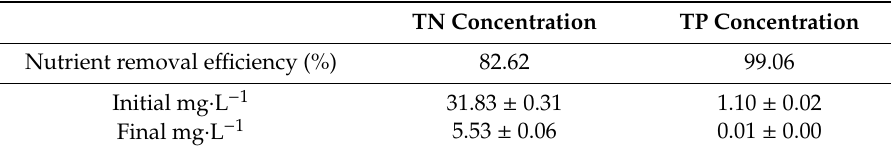
Table 3. Nutrient removal e ffi ciency of Monoraphidium sp.